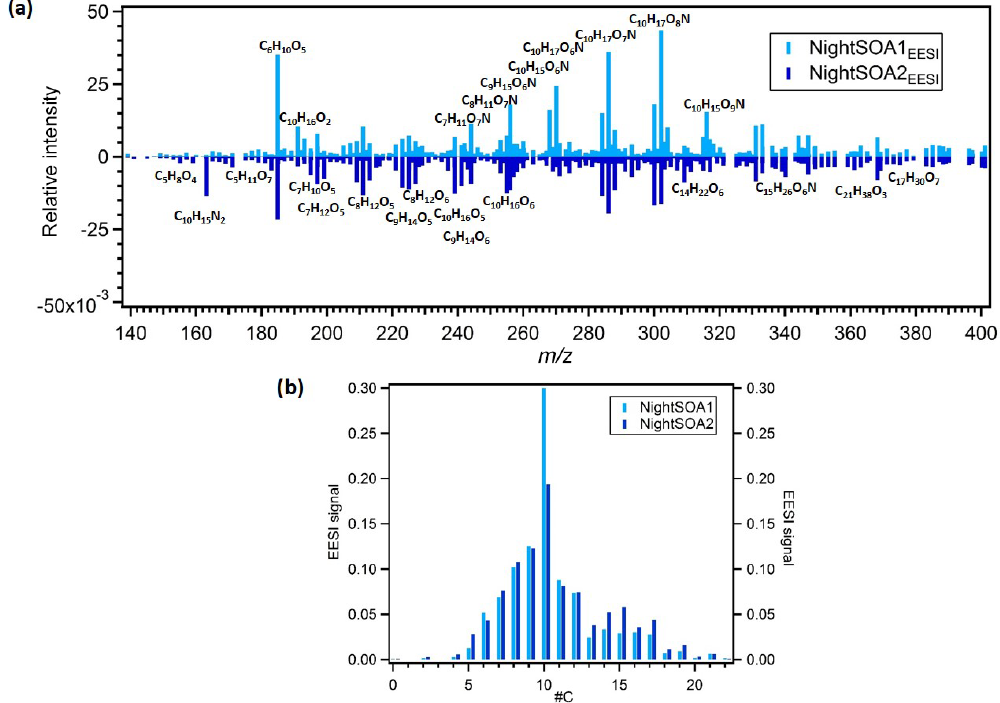
Figure 7. (a) Mirrored mass spectra of EESI NightSOA1 and NightSOA2. Factor profiles are first weighted by their molecular weight to represent equivalent mass concentrations (ags − 1 ) and then normalized such that the sum of each spectrum is 1. (b) Histogram of normalized profile signals distributed across bins of carbon atom